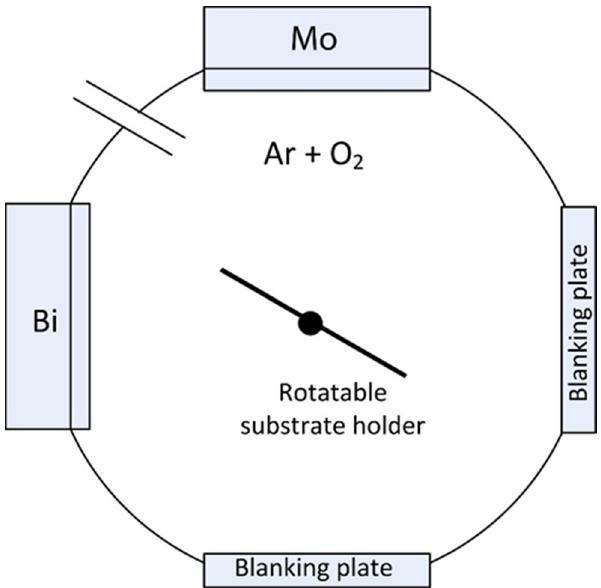
Figure 1. Schematic representation of Teer UDP450 sputtering rig.